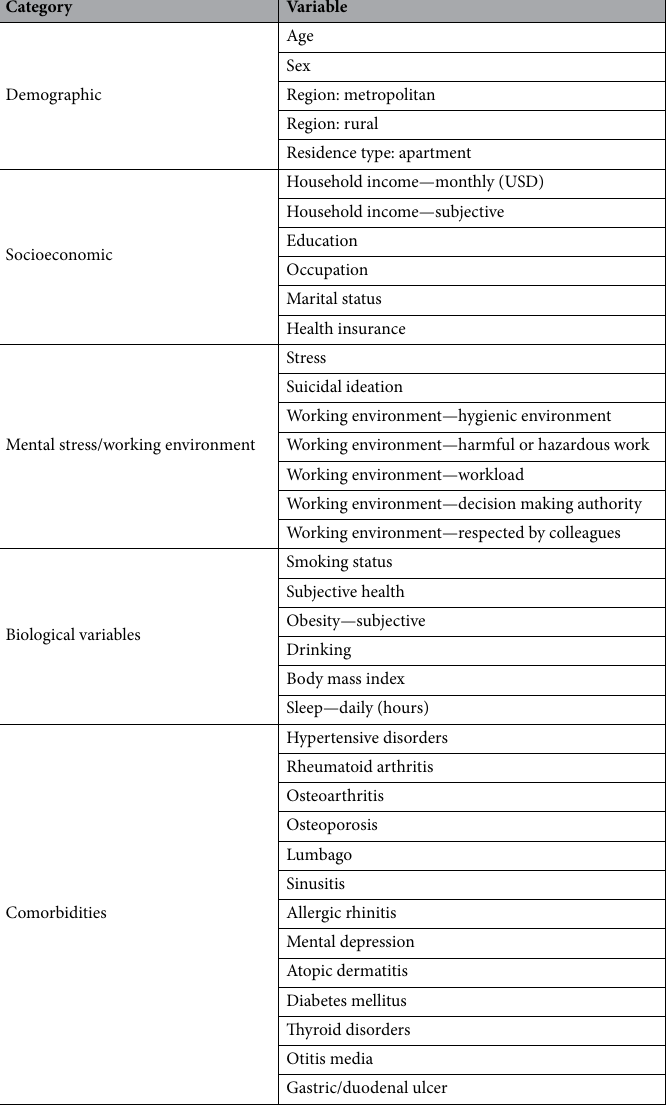
Table 1. Relevant variables from the Fourth Korea National Health and Nutritional Examination Survey.